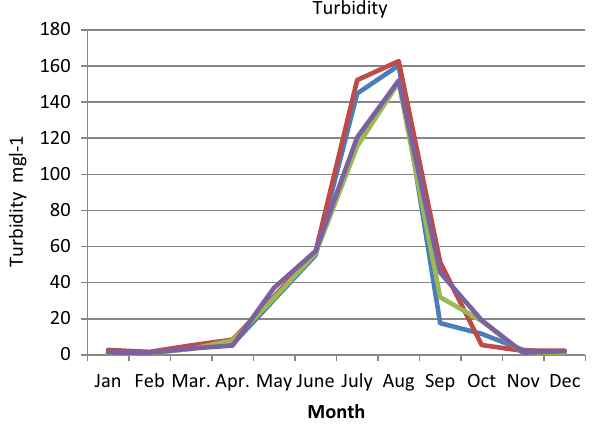
Fig. 11 Monthly recorded Tur- bidity (NTU) of maneri Phase I and II -site I & II of